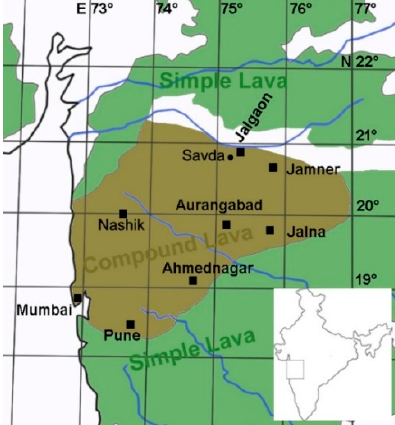
Figure 1. Map of the western and central part of the Deccan Volcanic Province (DVP), India.